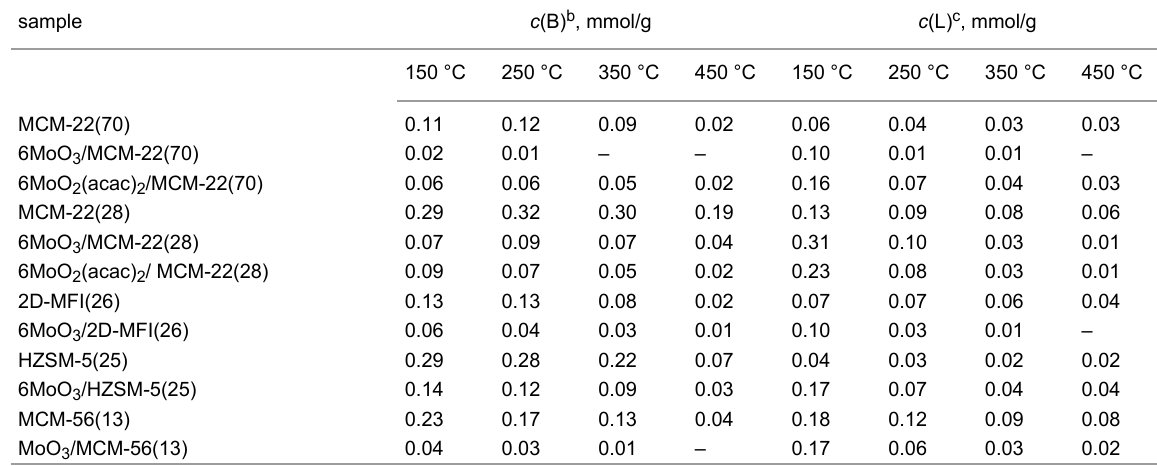
Table 2: Acid site concentrations in catalysts and corresponding supports. a